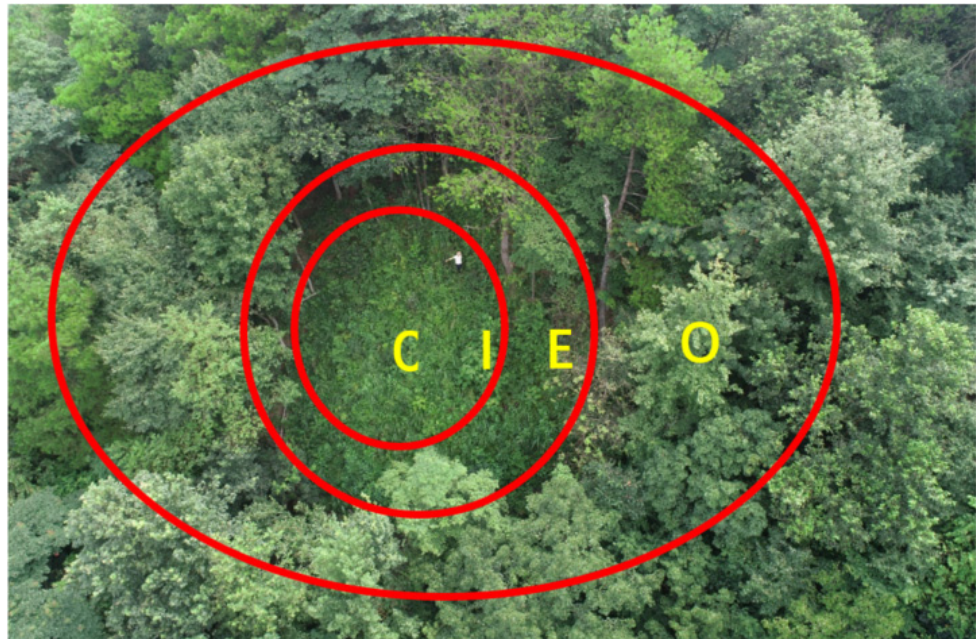
Figure 2. Soil samples from different sampling locations within the forest gaps. For sampling locations, C represents the center of forest gaps, I represents the location away from the center at 0.5 R distance, E represents the location at the edge of forest gaps, and O represents the location away from the center at 1.5 R distance (R, means gap